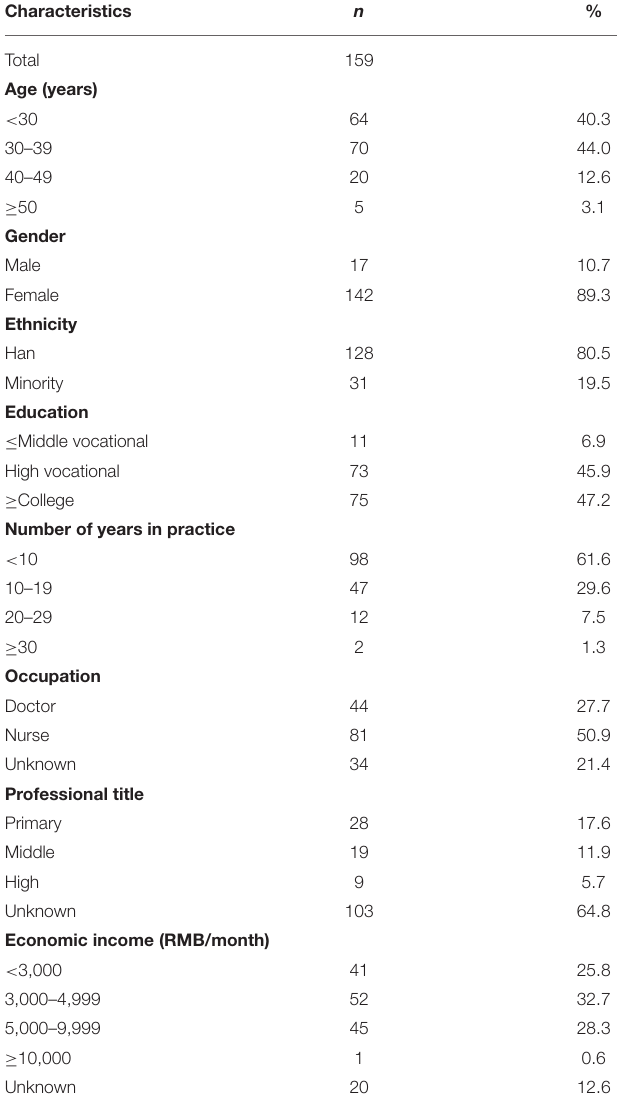
TABLE 1 | Basic demographic characteristics and professional information of the